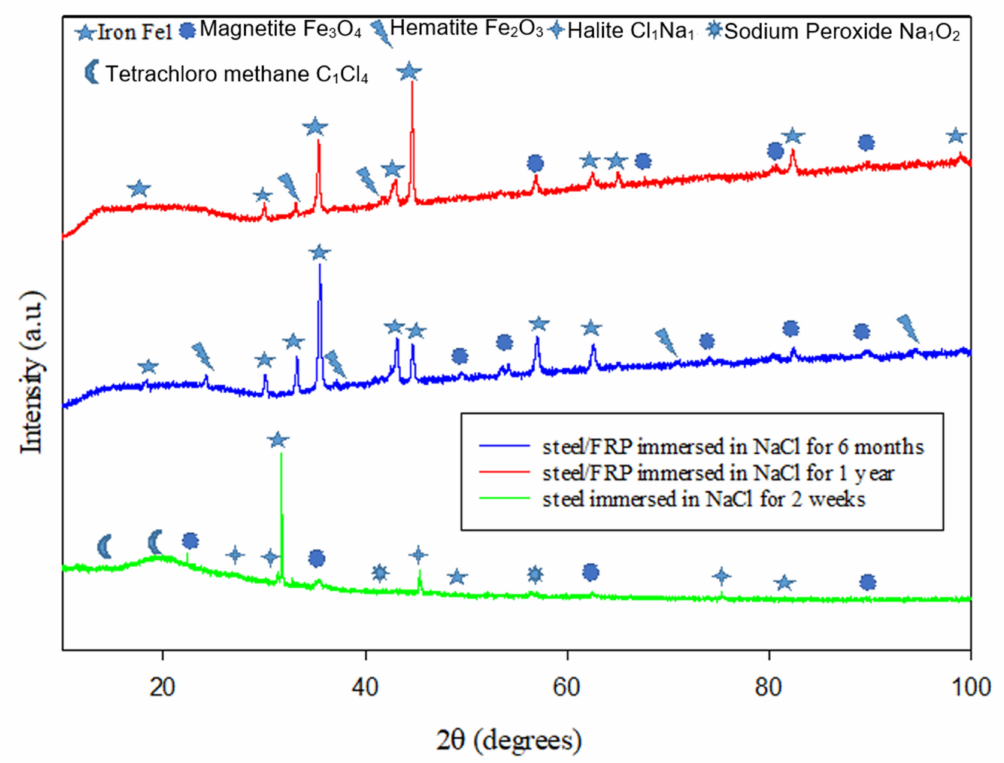
Figure 8. XRD patterns for the steel surfaces after immersion in NaCl